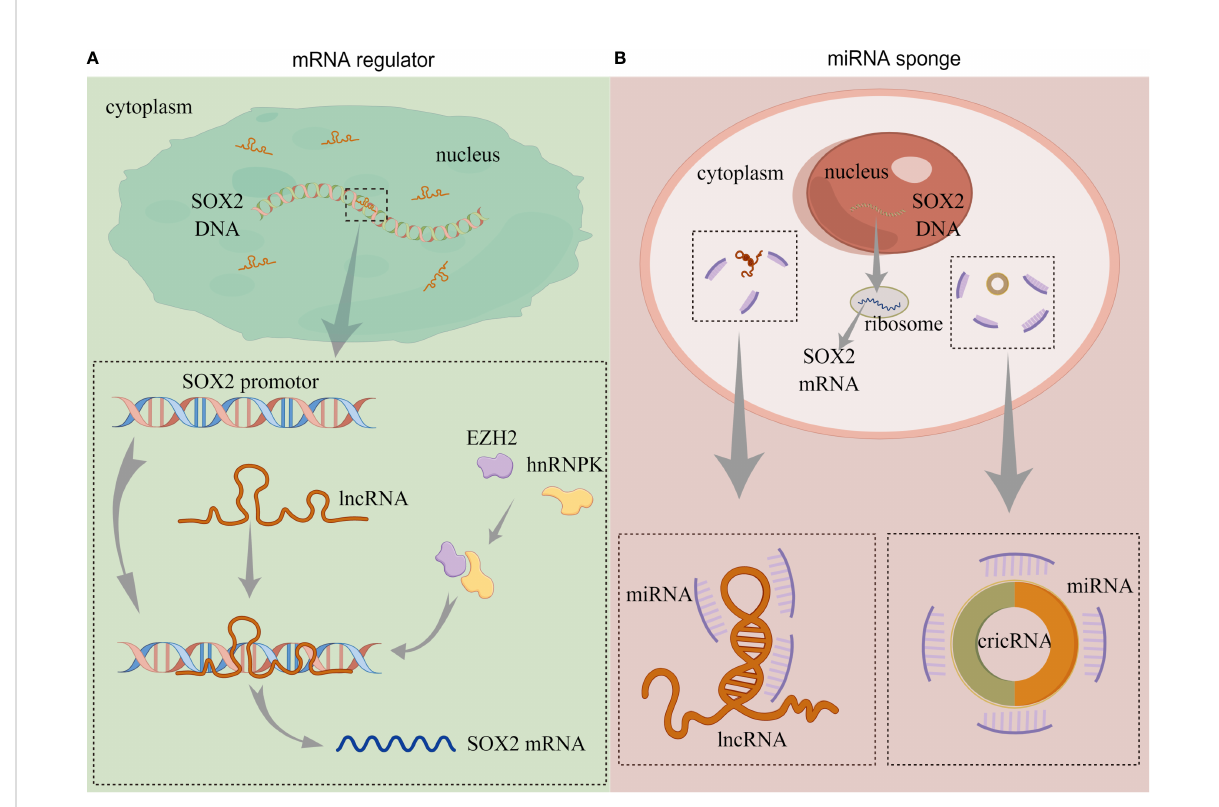
FIGURE 2 The functions of non-coding RNAs. (A) lncRNA directly regulates SOX2 expression. (B) lncRNA and circRNA act as miRNA sponges to regulate SOX2 expression. (lncRNA, long-non coding RNA; circRNA, circularRNA; miRNA, microRNA). By